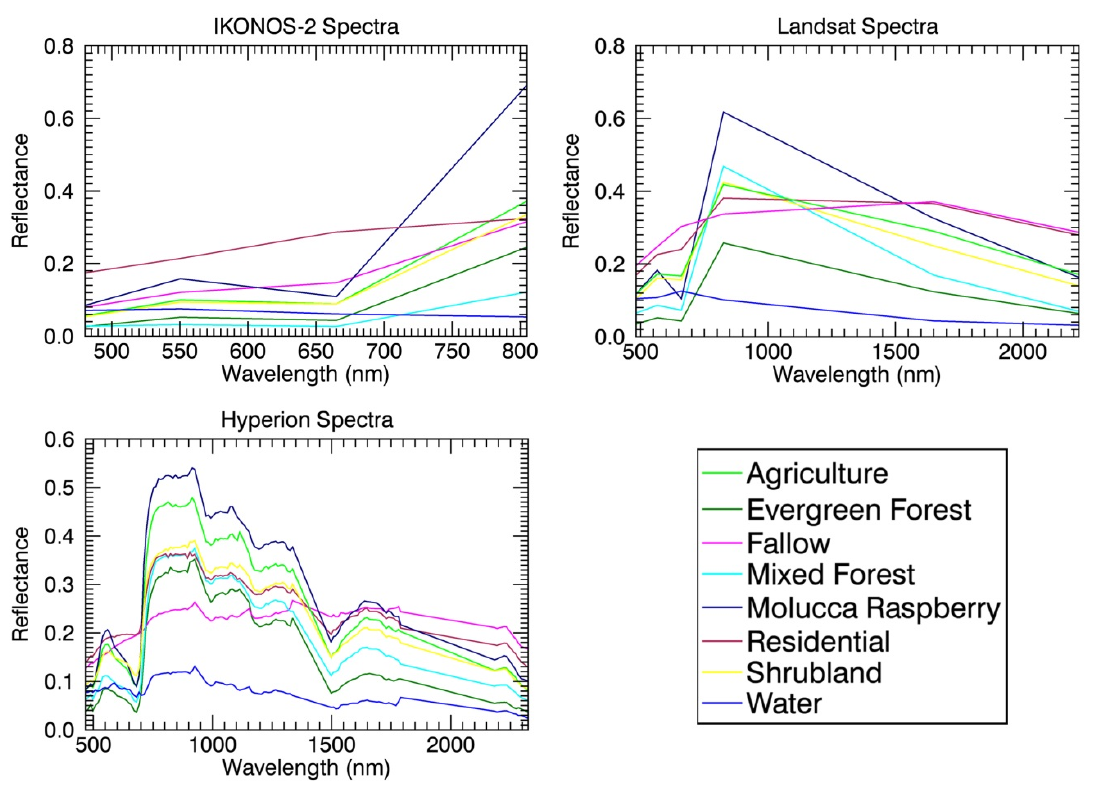
Figure 4. IKONOS-2, Landsat, and Hyperion spectra of major land cover